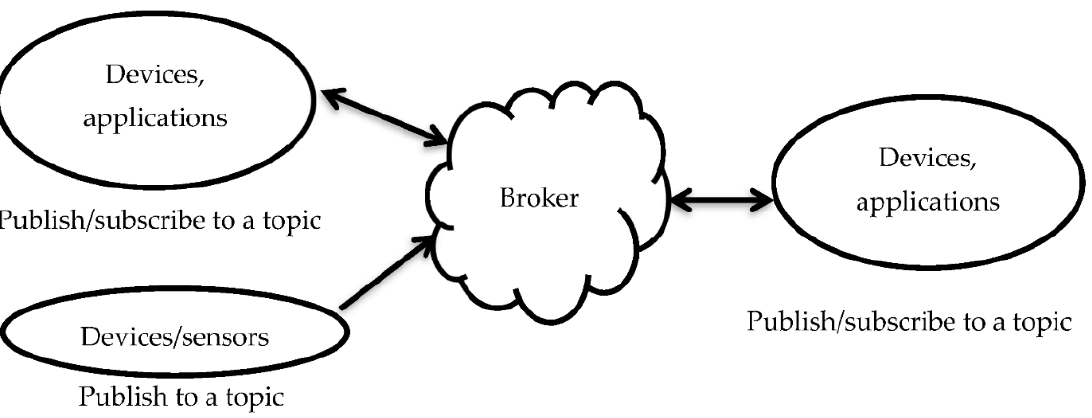
Figure 3. Architecture of the MQTT protocol. Many devices that can subscribe can also publish, but the reverse is not always the case.